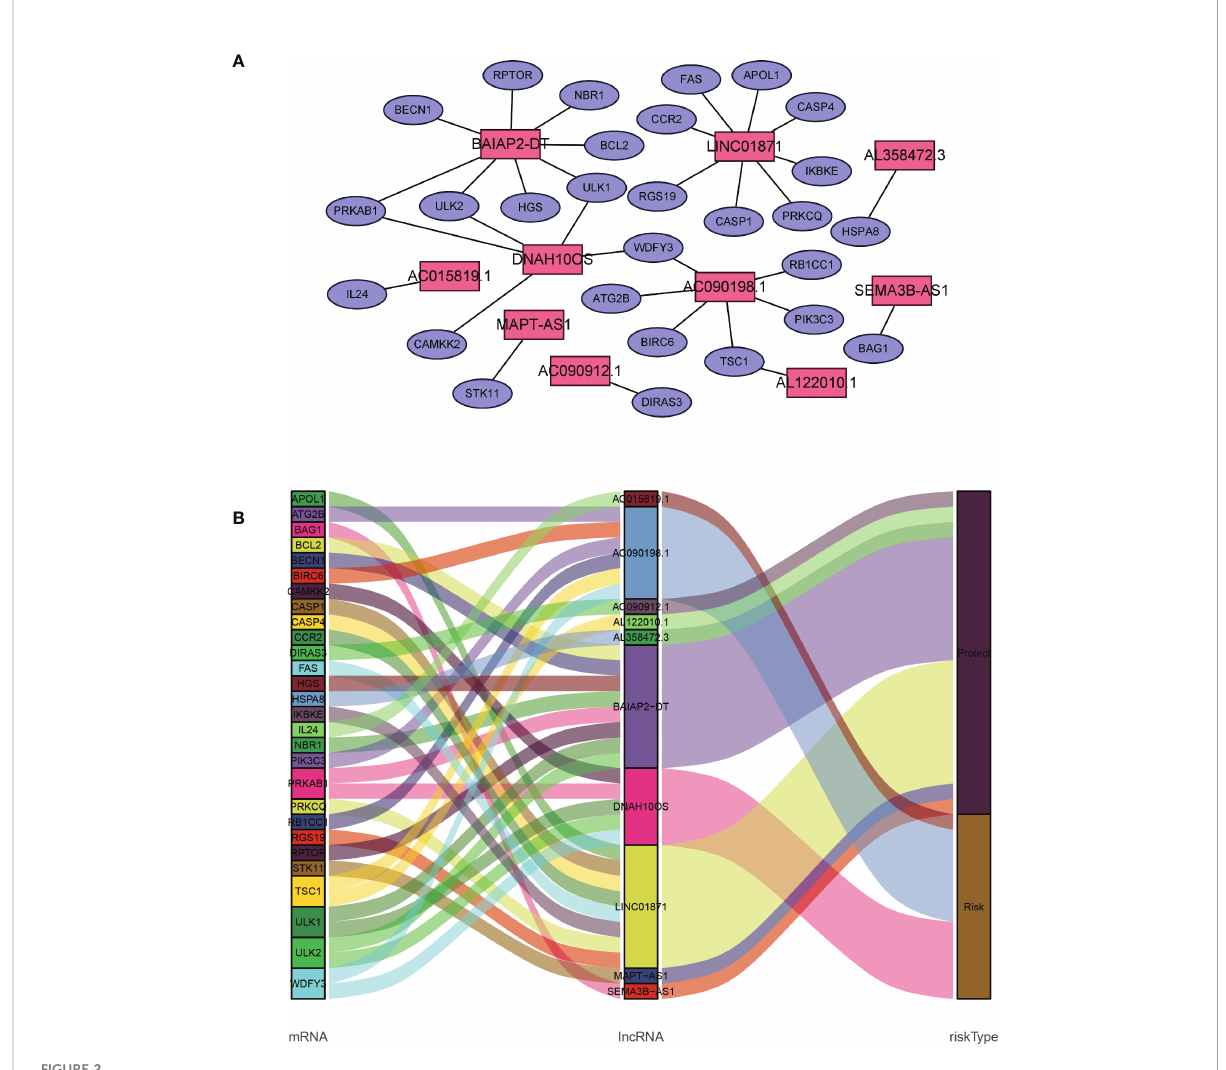
FIGURE 2 Description of the regulatory relationship between ARlncRNAs and ARGs in BRCA. (A) Co-expression network of ARlncRNAs and ARGs created using Cytoscape 3.8.2. (B) Co-expression of ARGs and ARlncRNAs and the prognostic value of 10